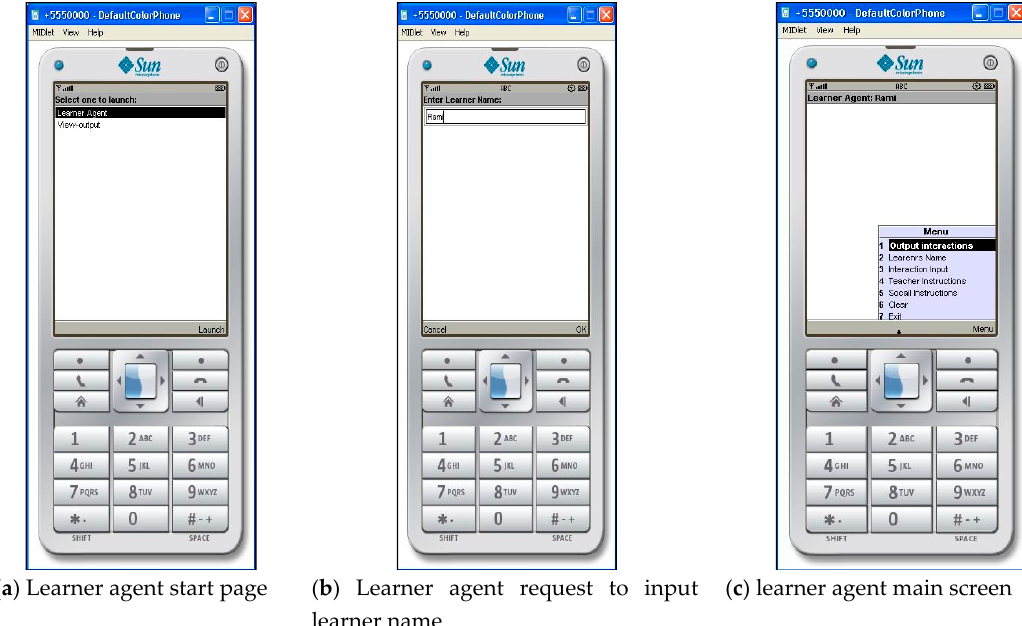
Figure 12. Mobile Learning graphical user interface (GUI) — the learner agent.